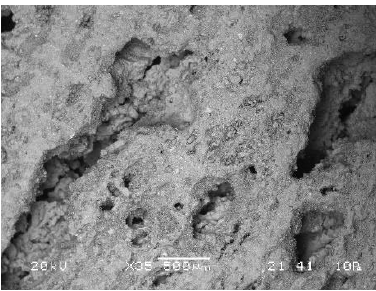
Figure 18. SEM micrograph of AAF prepared with 25 g of mixture ζ 4 , 50 g of precursor, 1% of Na-perborate, and 1% of Na-dodecyl sulphate.